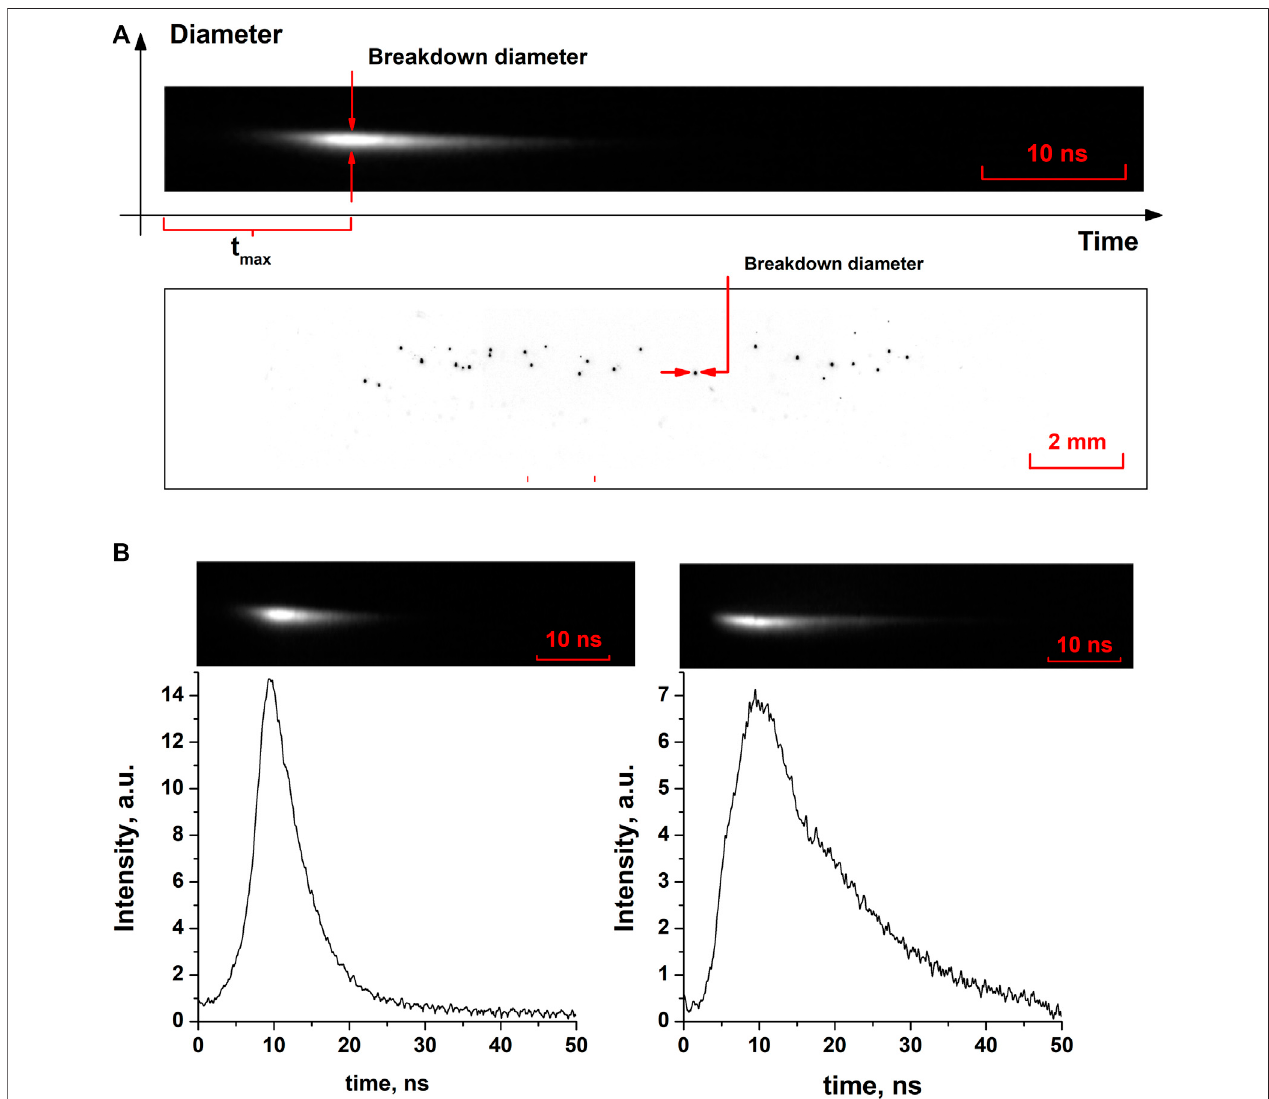
FIGURE2|(A) — Imagesofanindividual fl ashofopticalbreakdownobtainedwithastripcamera (top) ,imagesofopticalbreakdownduringirradiationofacolloidof Fe nanoparticles in the negative (bottom) ; (B) — Intensity of individual fl ashes depending on time: Flash duration — 8 ns (left) , fl ash duration — 15 ns (right) .